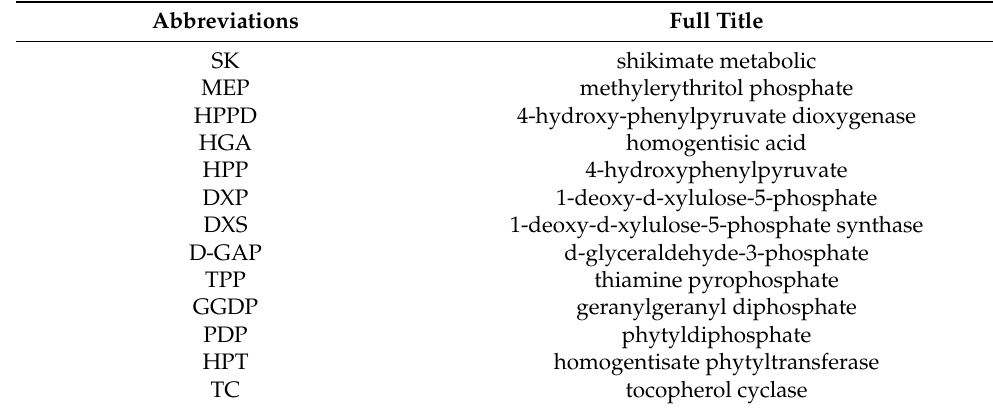
Table A1. The following abbreviations are used in this